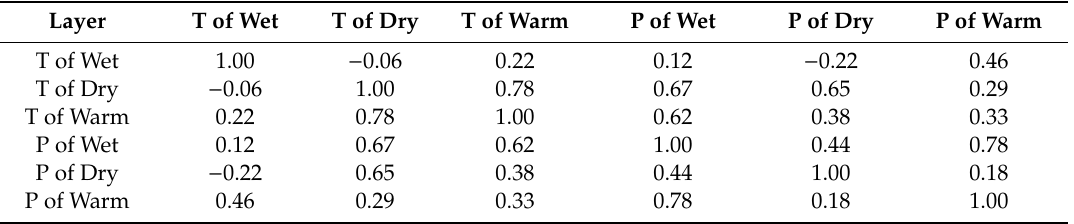
Table 1. The correlation matrix for six selected bioclimatic variables which includes average temperature ( ◦ C) and precipitation (mm) for wettest, driest, and warmest quarters. Abbreviations are: Temperature (T), Wettest (Wet), Driest (Dry), Warmest (Warm), Quarter (Q), and Precipitation (P).